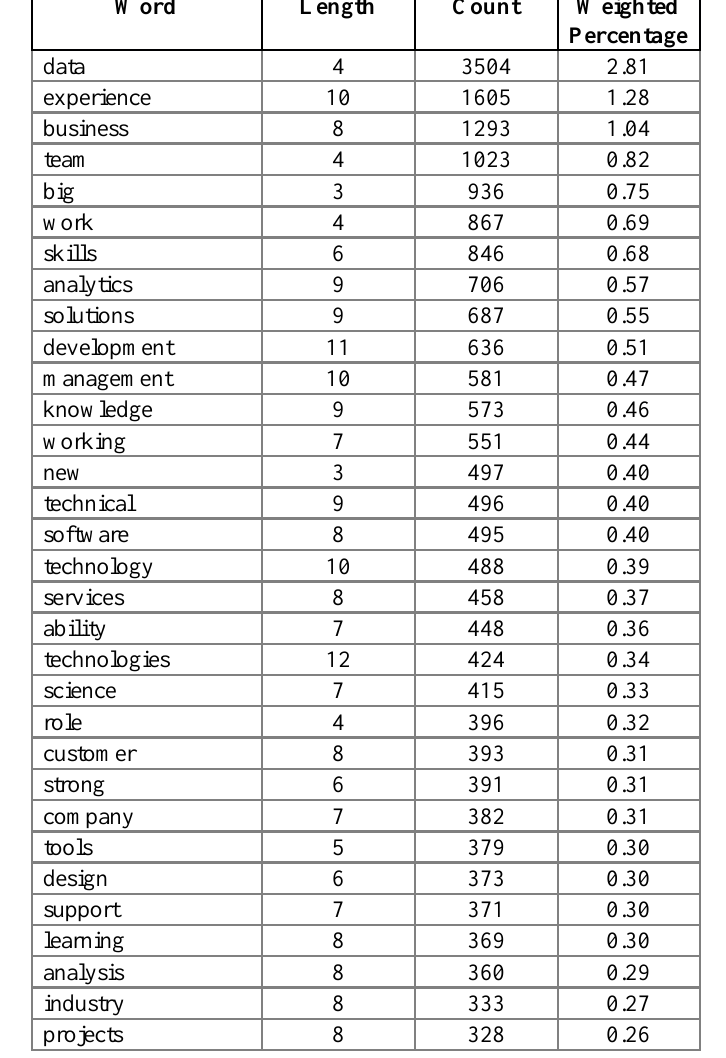
Table 1: The 100 Most Frequent Words in the Dataset Word Length Count